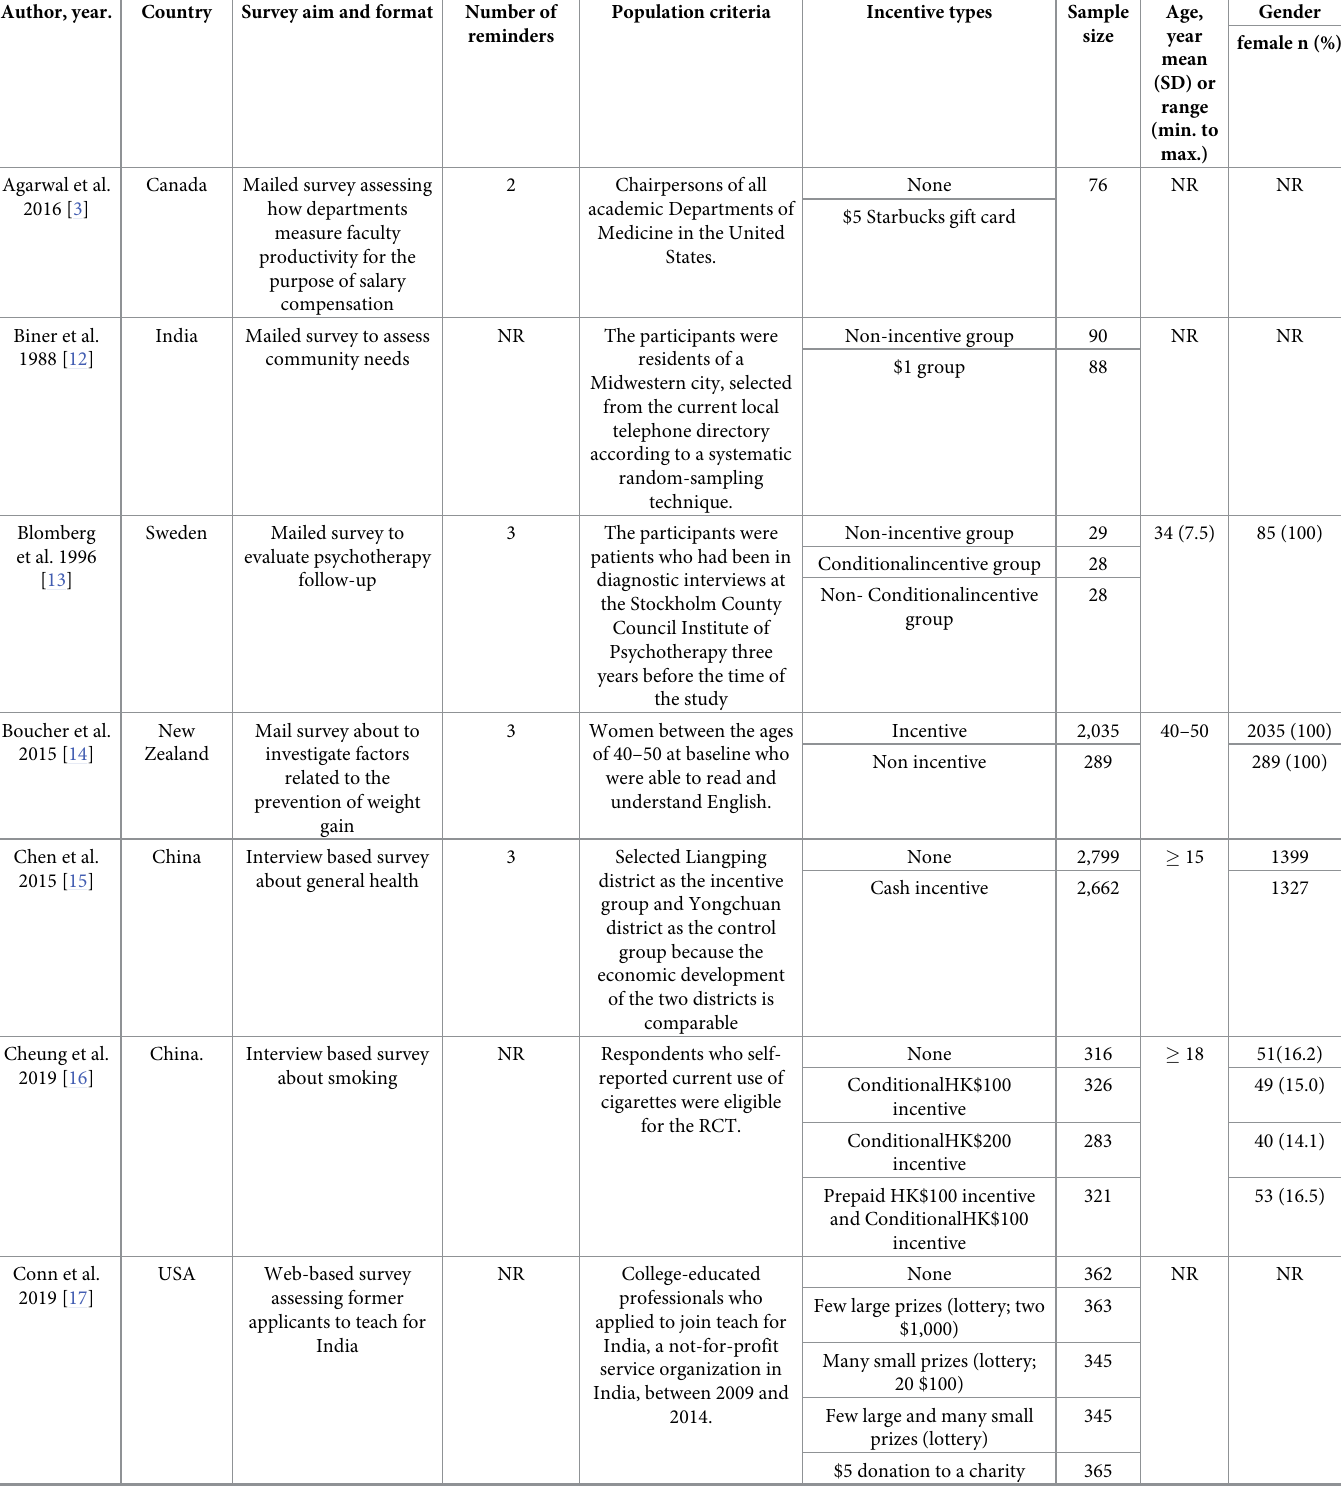
Table 1. Characteristics of the included